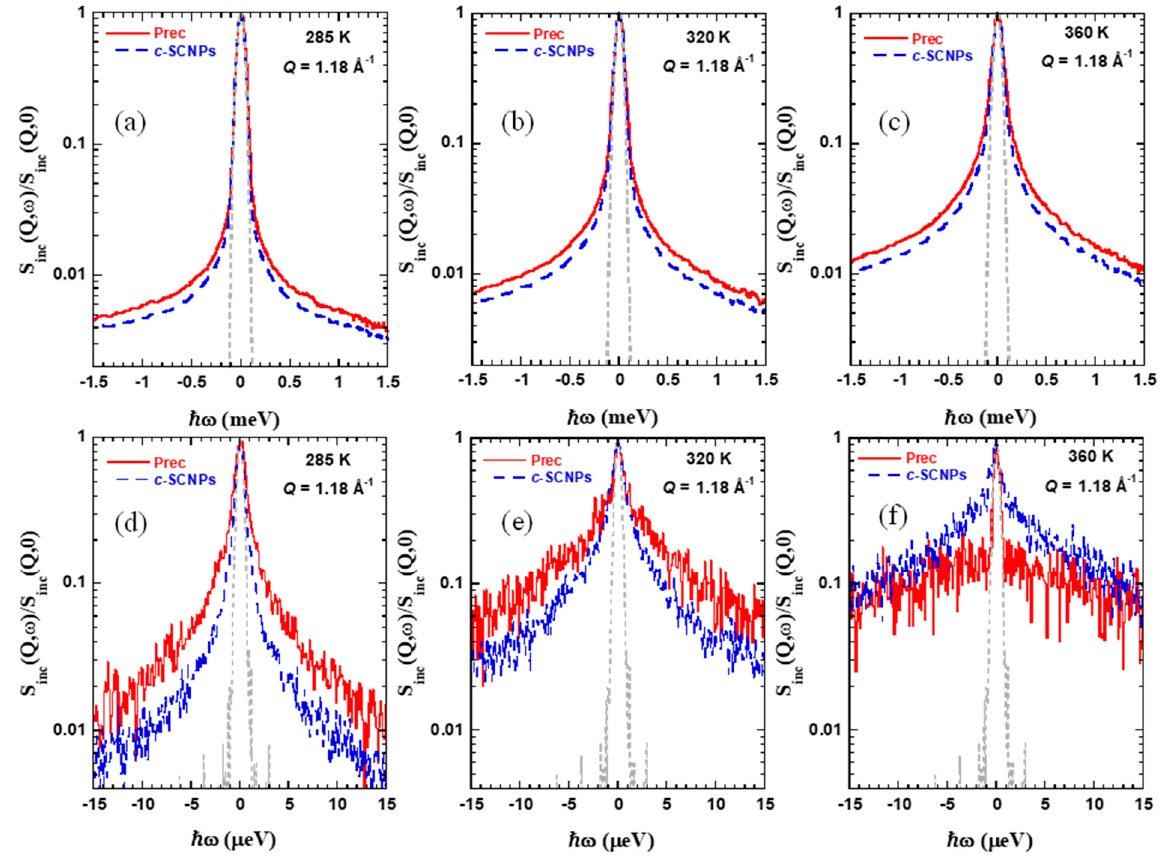
Polymers 2021 , 13 , x FOR PEER REVIEW 12 of 18 Figure 5. Normalized IN5 ( a – c ) and IN16B ( d – f ) spectra obtained at Q = 1.18 Å − 1 and the different temperatures indicated for Prec (solid line) and c -SCNPs (dashed line). The dotted line shows the instrumental resolution function.